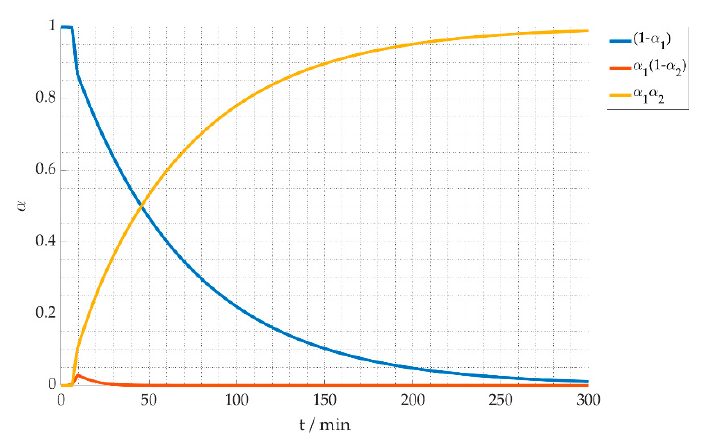
Figure 12. Stabilization degree 𝛼 at temperature of 300 °C.